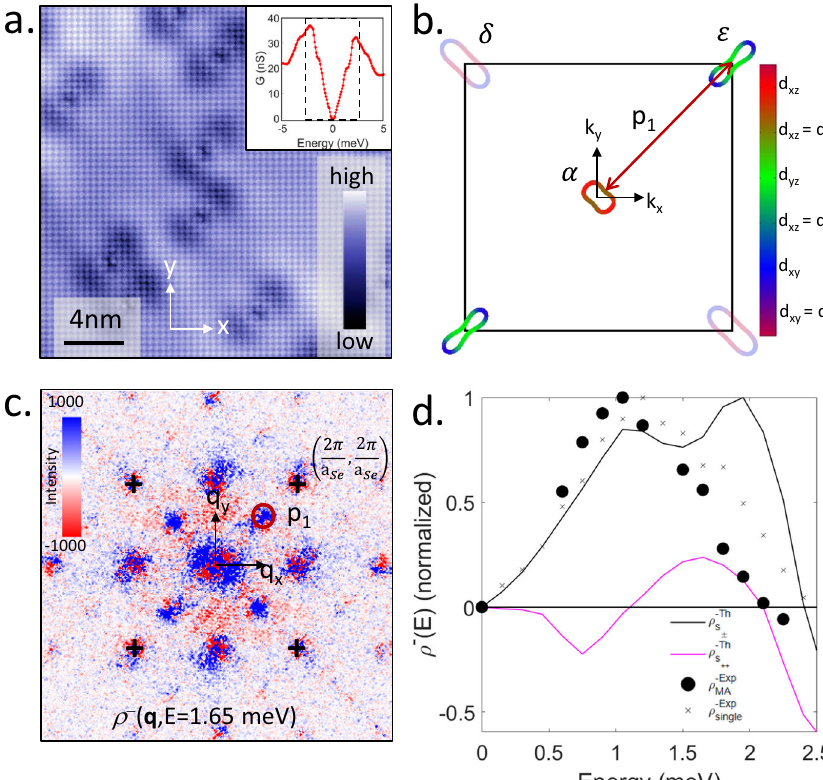
Fig. 2 Demonstration of MAHAEM for FeSe. a Topography of FeSe showing the type of defects (Fe-atom vacancies) used for analysis. The x - and y -axes are along top Se – Se atoms. Inset shows the differential conductance spectrum recorded at a point on superconducting FeSe. The dashed rectangle represents the energy limits of the high-resolution d I /d V maps used herein for ρ − ( q , E ) analysis. b Fermi surface of FeSe showing the scattering between hole-pocket α and electron-pocket ε with scattering vector p 1 , which is the subject of study. The delta pocket is predicted in LDA calculations, hence it is shown dim in the image, but is now reported not to exist in reality 6,38 . Due to the orbital content, the scattering between quasi-parallel Fermi surfaces would be strongly suppressed in this orbitally selective material 6 . c ρ (cid:2) ð q ; E ¼ 1 : 05meV Þ MA calculated using Eq. (9) for a FOV containing 17 Fe-vacancies. The circle denotes the region where the α ! ε scattering occurs and we q ; E Þ over the q in this region. Black crosses denote the Bragg peaks. d The integrated ρ (cid:2) E Þ (dots, black) from our integrate the ρ (cid:2) MA ð MA ð MAHAEM analysis of FeSe compare to the theoretical predictions from an accurate band- and gap-structure model of FeSe for s ++ (solid, pink) and s ± (solid, black) superconducting energy gap symmetry, and to measured ρ (cid:2) Exp ð E Þ (crosses, black) from single impurity analysis as single reported in ref. 6 . Clearly, the single atom ρ (cid:2) Exp ð E Þ and the MAHAEM ρ (cid:2) MA ð E Þ are in good agreement. Note that the 2D plots may show both red single and blue colors due to non-ideal nature of real experimental data. However, subsequent to the integration over relevant q -space region, the ρ (cid:2) E Þ is well de fi ned as demonstrated MA ð